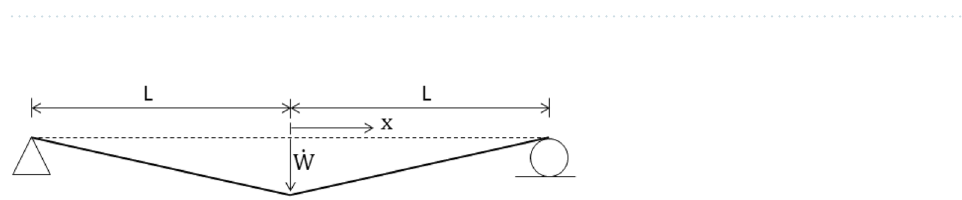
Figure 16. Distribution of transverse velocity during the plastic hinge moving second phase of motion ( ν > 1.5 ).